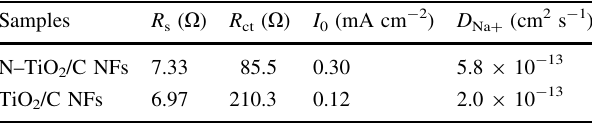
Table 2 Comparison of EIS parameters of TiO 2 /N–C NFs and TiO 2 / C NFs